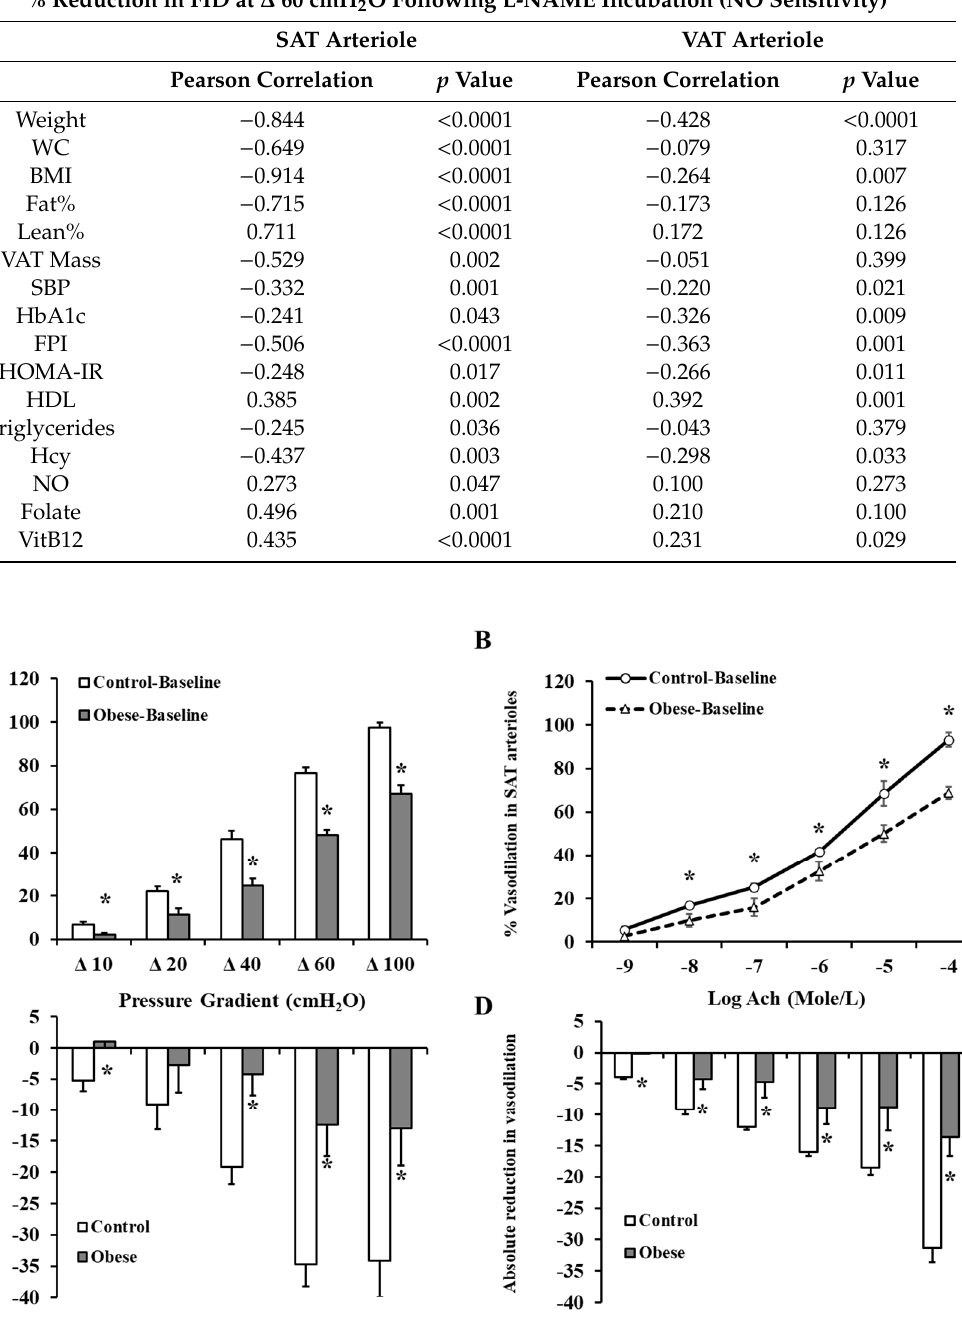
Table 3. Pearson correlations between No sensitivity in SAT and VAT isolated arterioles and di ff erent physical and cardiometabolic variables.